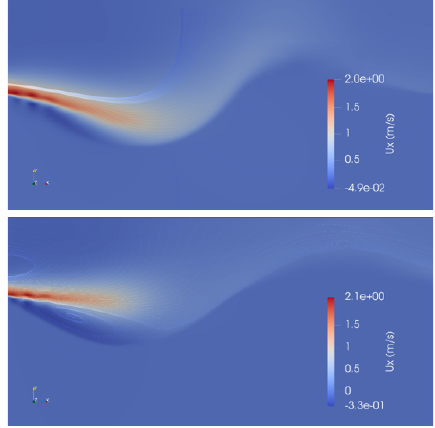
Figure 7: 3D numerical results of the water flow jet streamlines downstream of the sluice gate of aperture b 0 = 1 cm with Q = 11 . 5 l / min at two times t = 1 s (top) and t = 10 s (bottom).